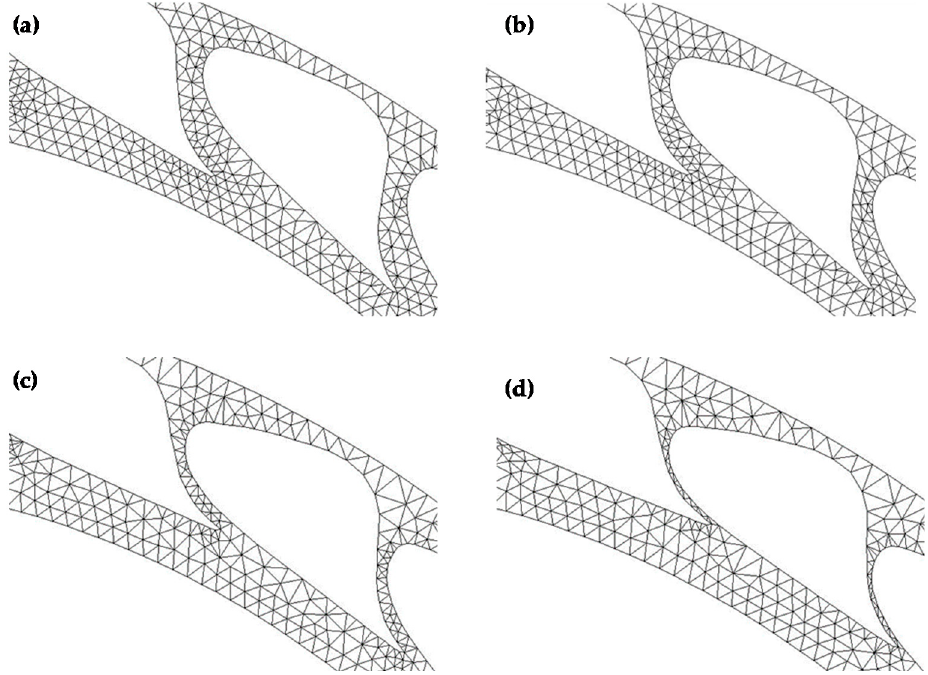
Figure 4. Mesh motion of guide vanes with respect to time t from an opening angle of 9.84° to 0.8° over an 8 s period. ( a ) t = 0 s; ( b ) t = 2 s; ( c ) t = 6s; and, ( d ) t = 9 s.